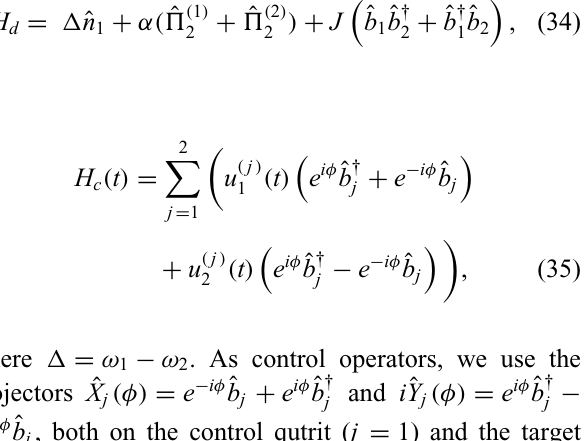
two-qubit CNOT gate. The range of values (cid:7) , α , and φ , as